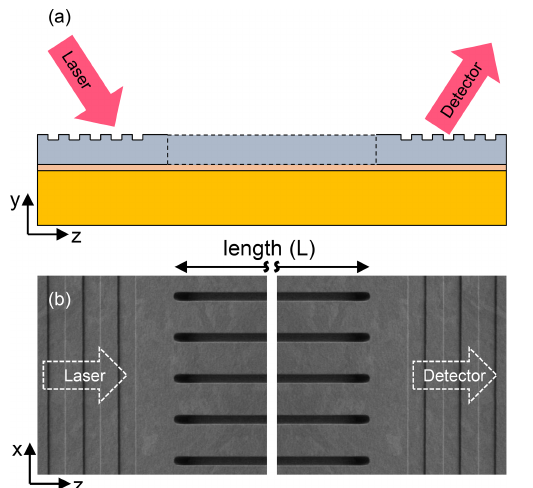
Figure 3. Concept and corresponding test structures to determine the waveguide damping. (a) Schematic representation of the per- formed damping measurement. Light from an external laser is cou- pled in via a grating, transmitted through the waveguide, and cou- pled out towards an external detector. (b) Stitched SEM image of a fabricated test structure (top view without